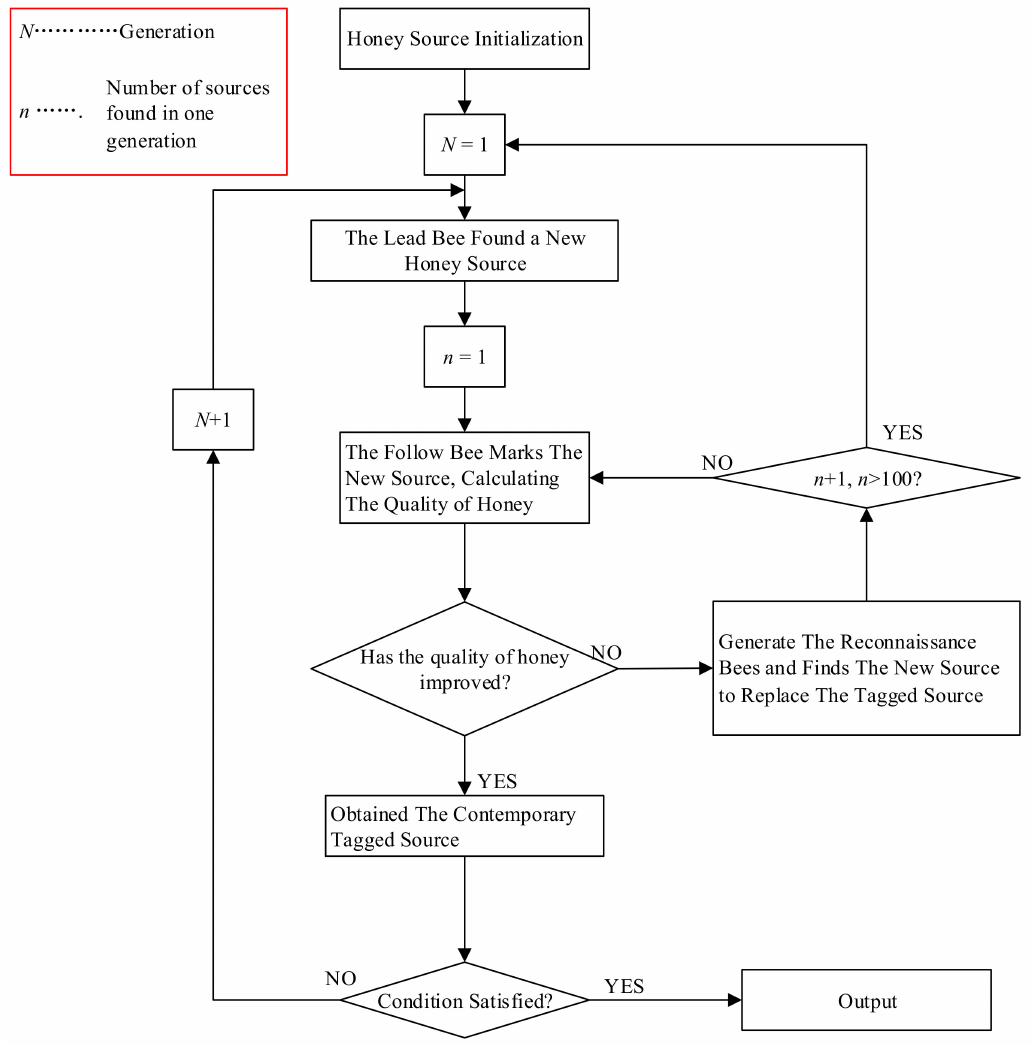
Figure 7. Flowchart of